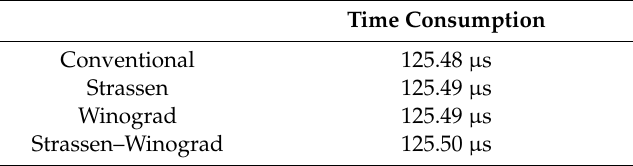
Table 1. Time consumption records for the different designs.